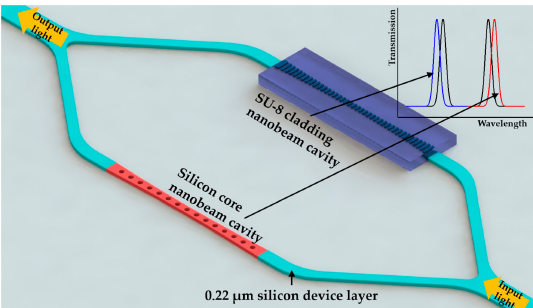
Figure 19. Sensitive temperature sensor based on nanobeam cavities (silicon core of positive thermo-optic coefficient in red and SU8 cladding of negative TO coefficient in